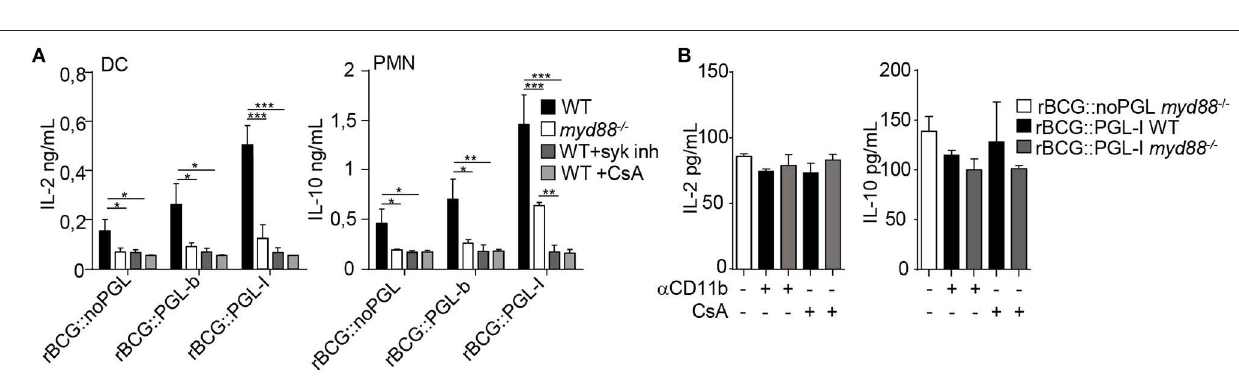
FIGURE 5 | rBCG::PGL-I preferentially triggers Syk/calcineurin/NFATc through CR3 to rewire innate cells (A) DCs or PMNs from WT or myd88 − / − mice were infected with the three rBCG strains at MOI of 5. WT cells were treated with GS-9973 to inhibit the Syk pathway, or CsA to block NFATc translocation 1h before infection. After overnight incubation supernatants were harvested to measure by ELISA IL-2 produced by DCs and IL-10 produced by PMNs. (B) Before infection of DCs or PMNs with rBCG::noPGL or rBCG::PGL-I as in (A) , cells were either incubated for 1h with anti-CD11b antibody M1/70 to block CR3-mediated entry, or exposed to CsA to block NFATc translocation as indicated. IL-2 produced by DCs and IL-10 by PMNs after overnight incubation were measured by ELISA. Data are presented as mean ± SEM ( n = 4). * P < 0.05; ** P < 0.01; *** P <